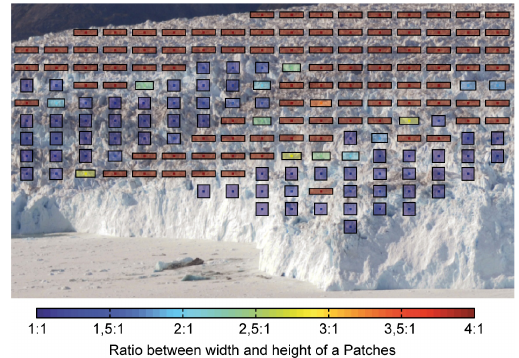
Figure 4. Patch shape definition depending on depth differences within a patch